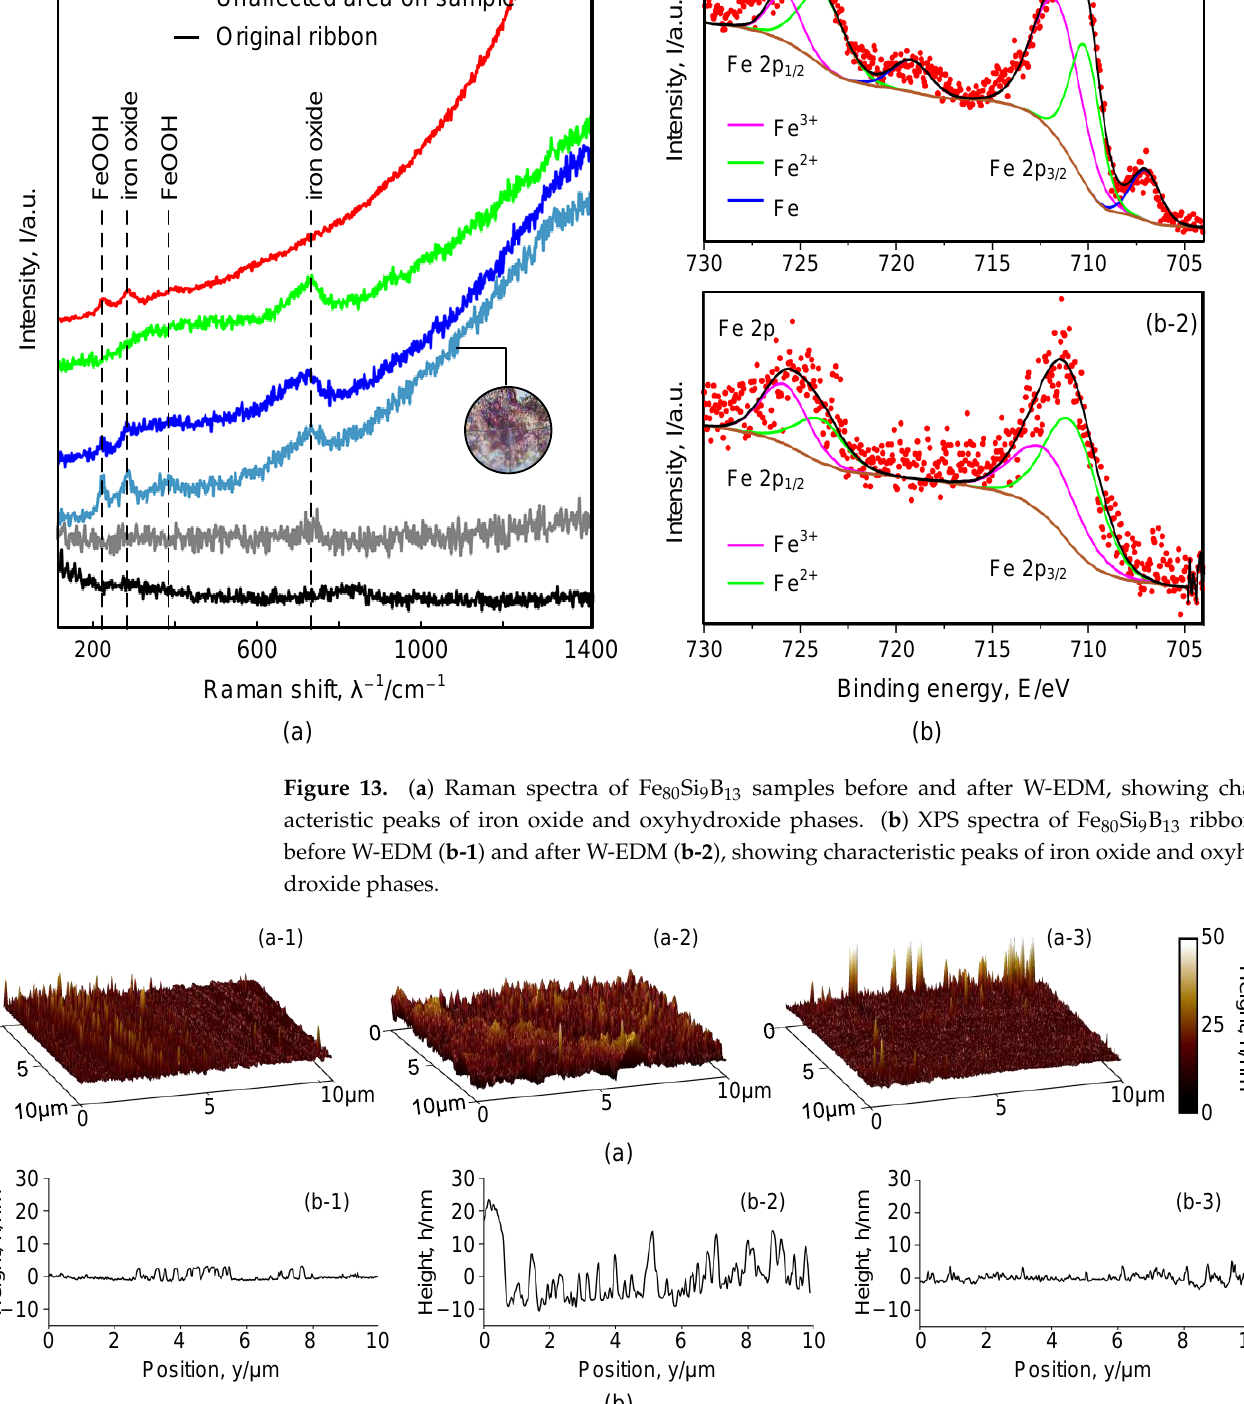
Figure 14. Surface profile of AA samples before and after W-EDM processing: ( a ) 3D profile of AA samples before and after W-EDM processing. ( a-1 ) the original ribbon, ( a-2 ) the W-EDM-processed edge, and ( a-3 ) the unaffected area on the processed sample. ( b ) Surface height distribution of AA samples before and after W-EDM processing. ( b-1 ) the original ribbon, ( b-2 ) the W-EDM-processed edge, and ( b-3 ) the unaffected area on the processed